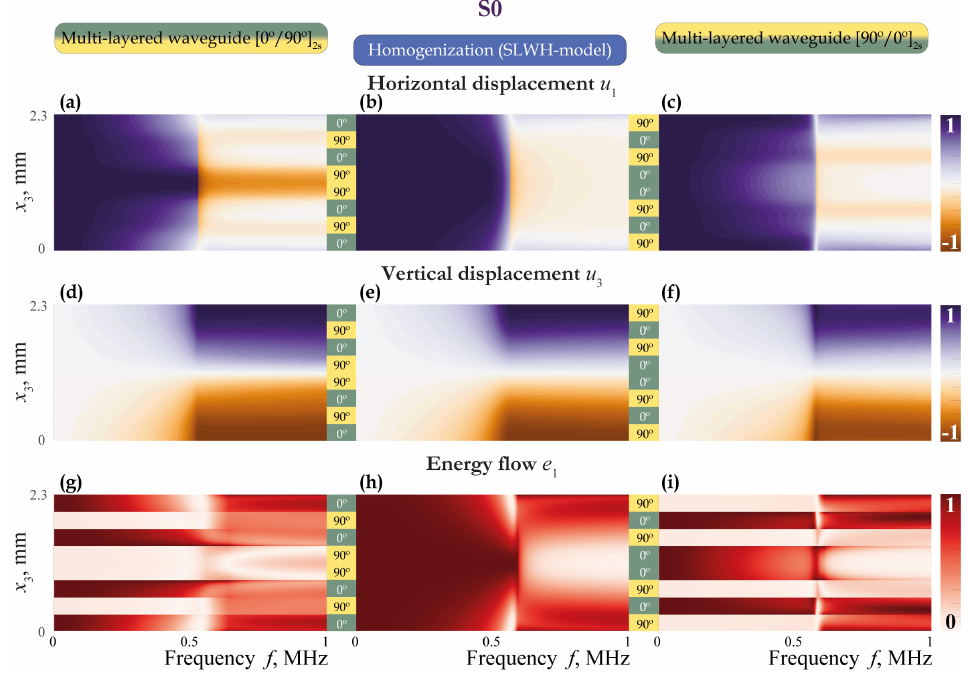
Figure 7. Eigenforms for the first fundamental guided wave S0 propagating in multi-layered waveg- uide [ 0 ◦ ,90 ◦ ] 2s ( a , d , g ), homogeneous waveguide according to the SLWH-model ( b , e , h ), and multi- layered waveguide [ 90 ◦ ,0 ◦ ] 2s ( c , f , i